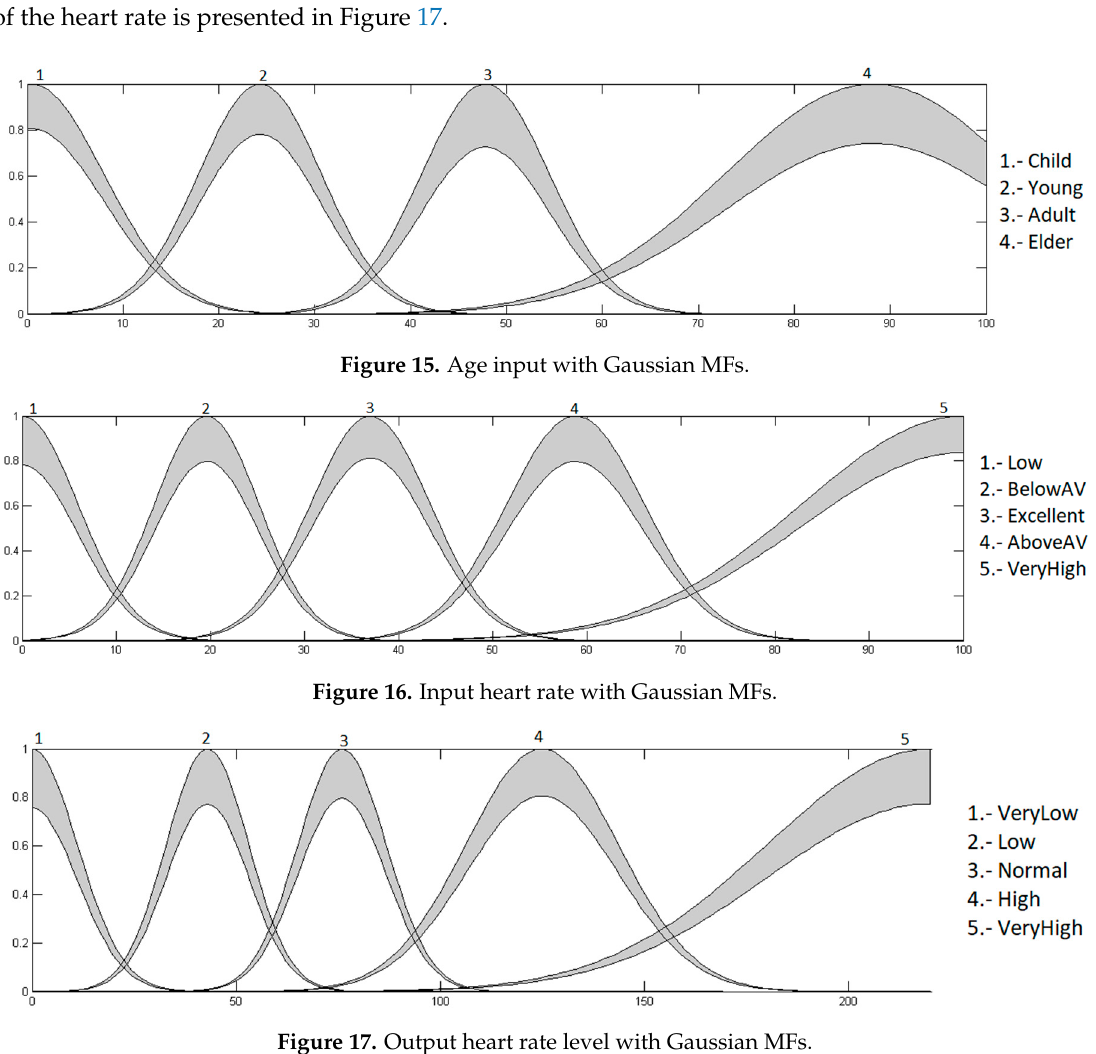
Figure 14. Output heart rate level with trapezoidal MFs.